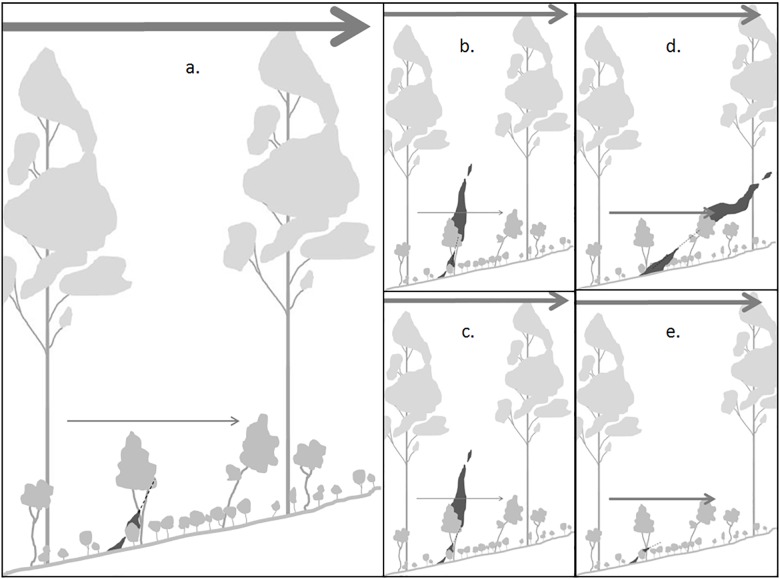
Effects of donor flammability, receiver ignitability and overstorey sheltering on fire severity.Wind speed is shown above and below the canopy by the solid arrows, with thicker and longer arrows showing greater wind speed. The trajectory of convective heat transfer is shown by the broken line. Four scenarios b to e are shown relative to the left scene a. The convective plume produced by the donor plant in a. intersects the receiver; however it is insufficient to ignite it. This is changed when in b the donor flammability is increased to give a larger flame that ignites the receiver, and in c when the donor flame is the same as in a but the receiver ignitability is greater. The flammability of the plants in scenarios d and e is the same as in a, but the wider tree spacing has reduced the overstorey sheltering so that the wind speed is greater at the level of the flame. This directs the plume through its neighbouring plants in d so that the flame depth is increased and the resulting larger flame ignites the receiver stratum. In scenario e, the plume passes over neighbouring shrubs or elevated stratum [7] so that they are not ignited and the flame dimensions remain unchanged from a The more acute angle of the plume, however, increases the distance to the receiver stratum so that the heat dissipates and that stratum is even less likely to ignite than in a.